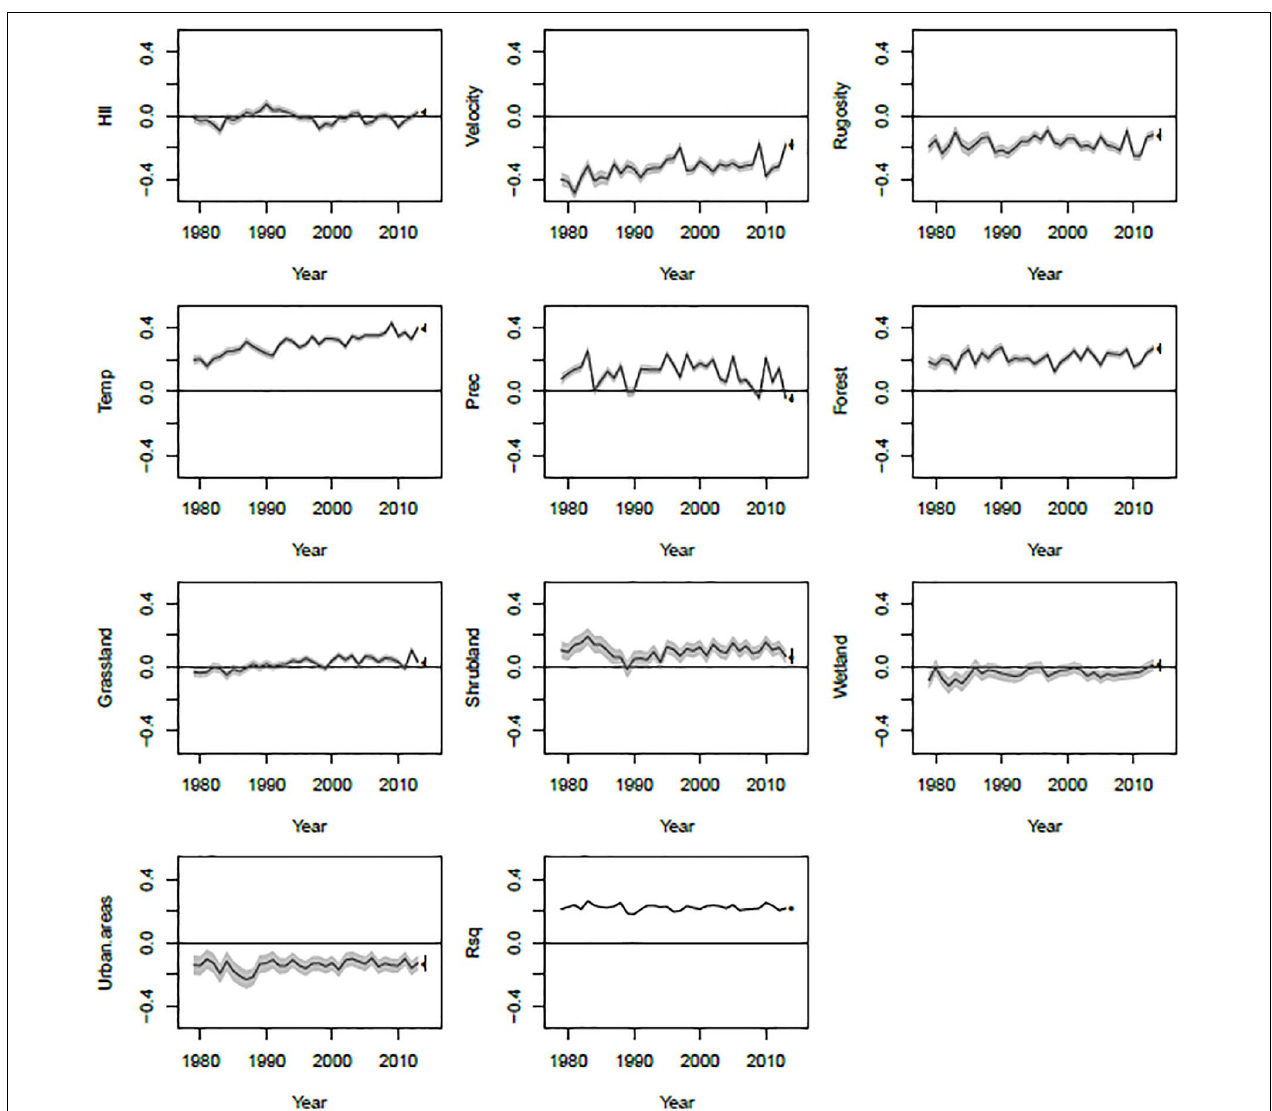
FIGURE 5 | Temporal dynamics of coefficients from linear models fit for each year of the study period. For each model coefficient, the black line shows the coefficient estimate and the gray region shows one standard error above and below the estimate. The dot and error bar indicates the coefficient obtained from a model using long-term averages for each variable instead of annual